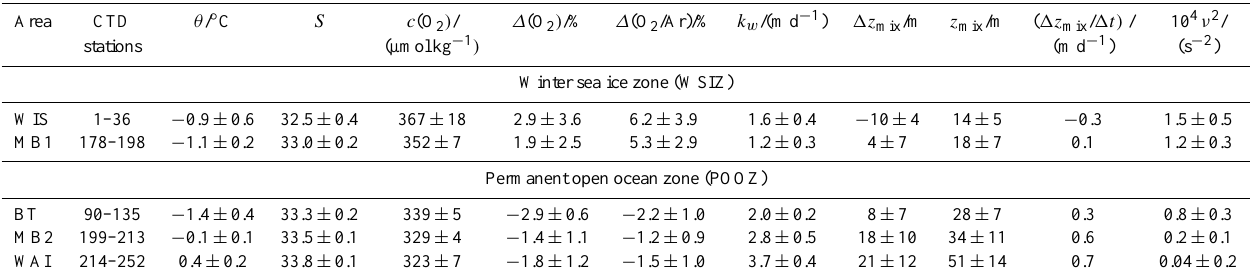
Table 1. Average ( ± 1 standard deviation) of the main measured and calculated variables in the mixed layer for cruise JR165 (summer 2007, Bellingshausen Sea). Results are categorized by area: WIS, Wilkins Ice Shelf; MB1, Marguerite Bay 1; BT, Belgica Trough; MB2, Marguerite Bay 2 and WAI, west of Adelaide Island (CTD stations in between the ones presented here are not included). 1z mix is the change in mixed-layer depth over 1t = 30 days prior to sampling. Positive values indicate a deepening of the mixed layer. ν 2 is the Brunt-V¨ais¨al¨a frequency based on the density change in the top 50m of the water